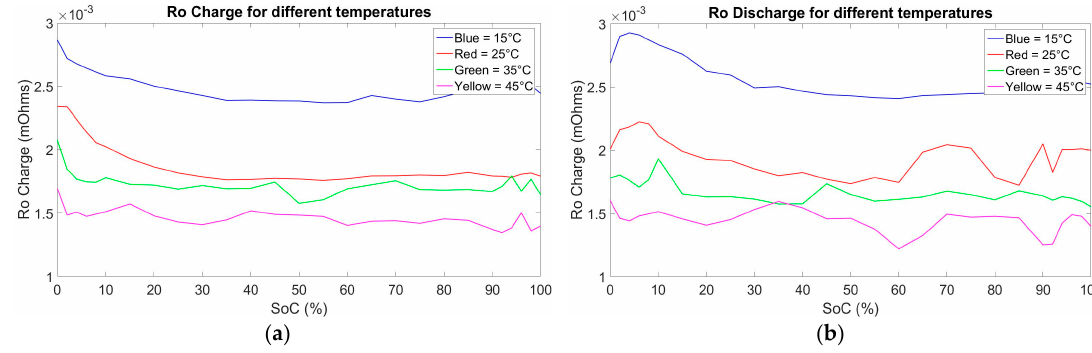
Figure 9. Internal resistance (R o ) for different temperatures ( 15 °C, 25 °C, 35 °C and 45 °C) : ( a ) R o charge; and ( b ) R o discharge.